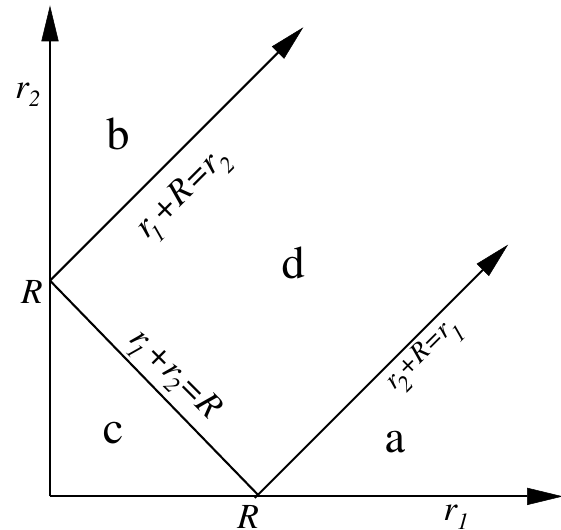
Figure 1. Regions of definition of the D l 2 m 2